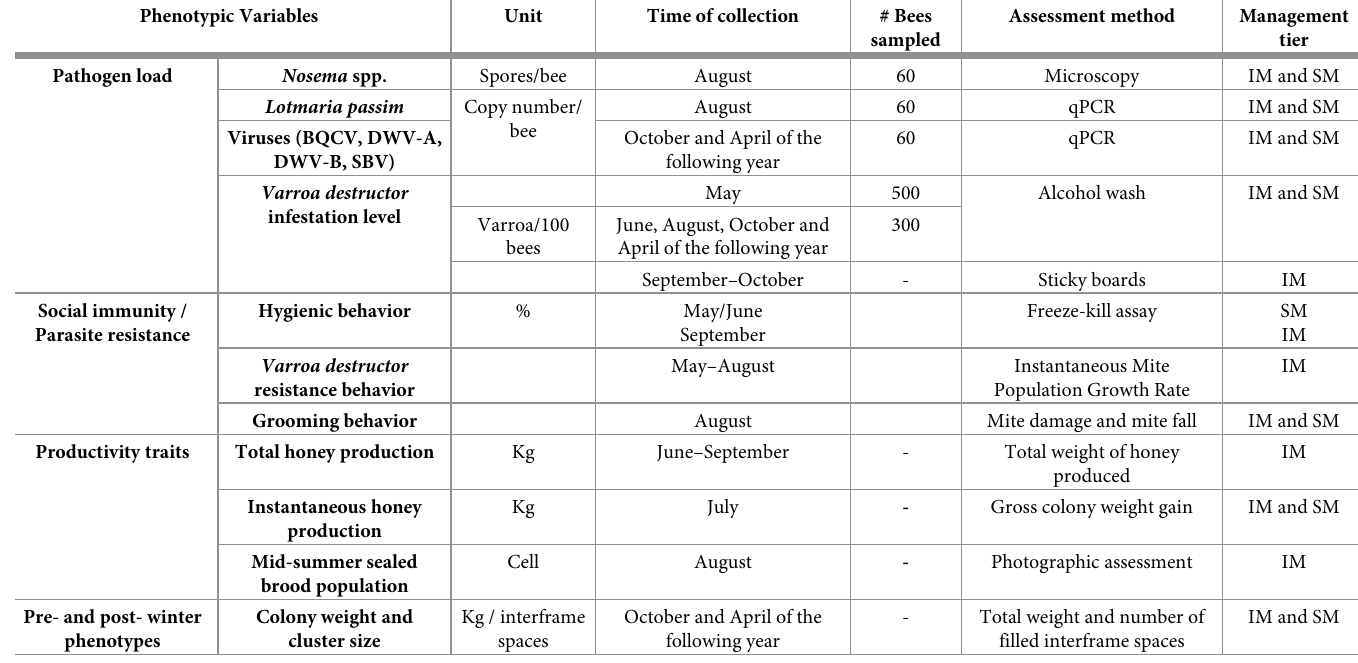
Table 2. List of phenotypic variables measured, time of sample collection, targeted sample size per colony, method of assessment and management tier sampled. Phenotypic Variables Unit Time of collection # Bees